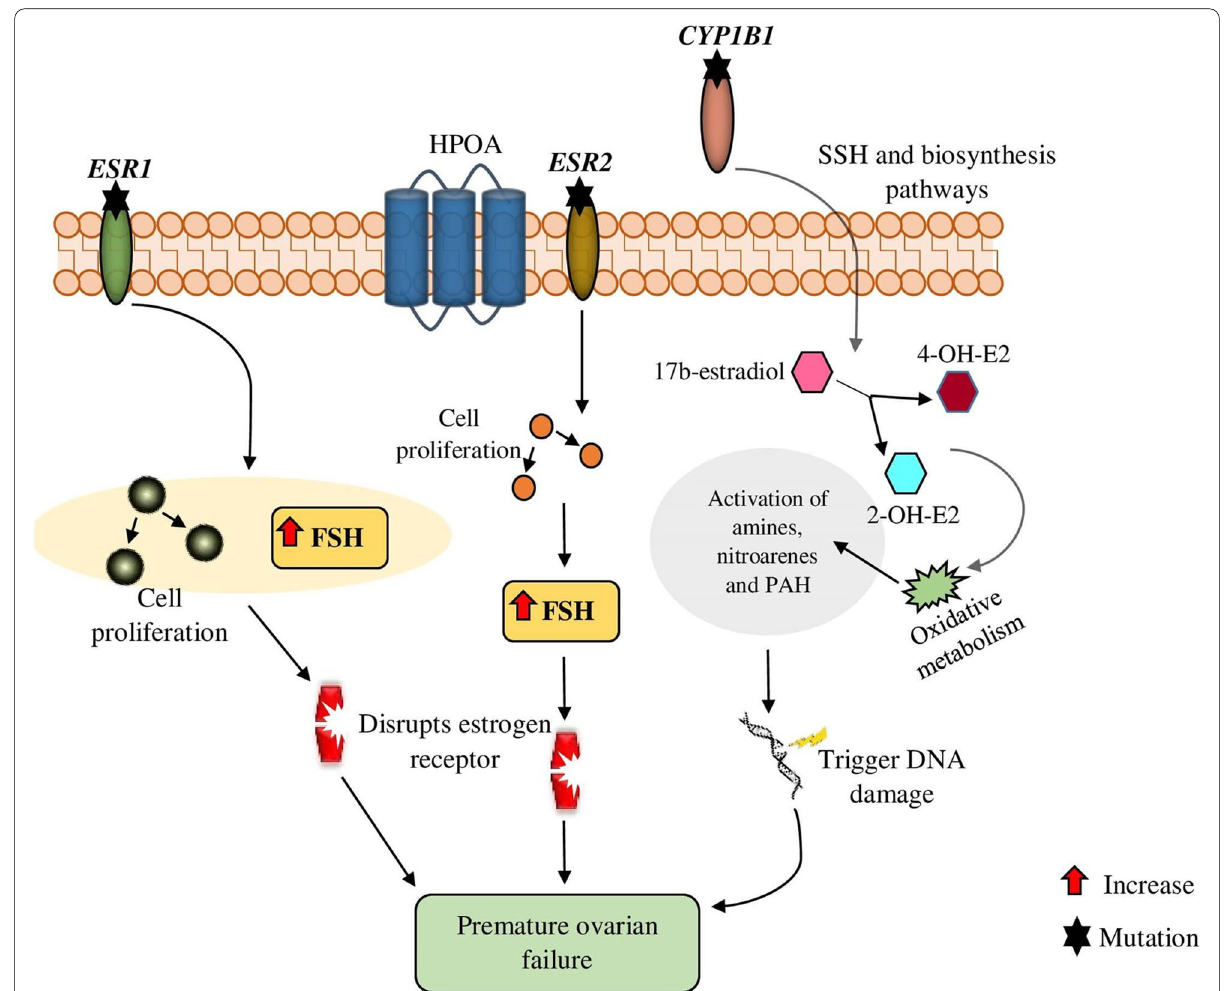
Fig. 3 Role of ESR1 , ESR2 , and CYP1B1 mutation in the pathogenesis of premature ovarian